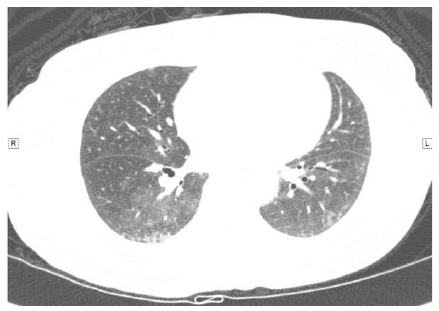
Figure 1: Chest tomography scan previous to treatment. T8 level with 10-millimeter sections. Pulmonary interstitium is affected bilaterally, with bronchiectasis on the lower lobes. Subpleural lines are preserved, suggesting unspecific interstitial pneumonia.